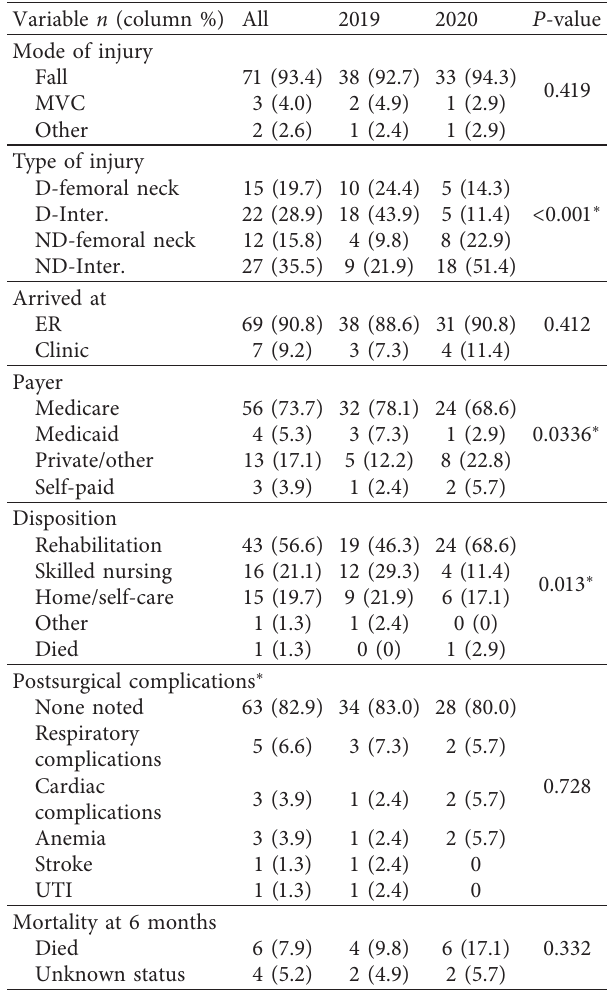
Table 2: Categorical clinical characteristics of patients. Variable n (column %)